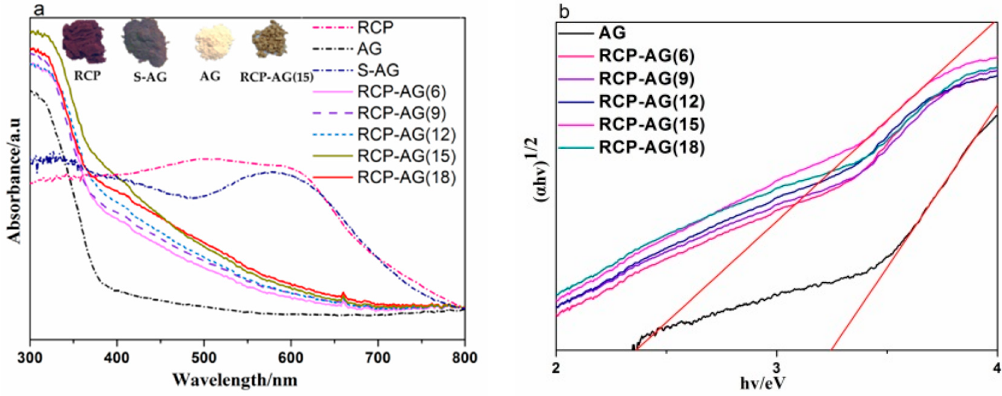
Figure 7. ( a ) UV-VIS diffuse reflectance spectra of samples; ( b ) optical band-gap for samples. Figure 7. (a) UV-VIS diffuse reflectance spectra of samples; (b) optical band-gap for samples.